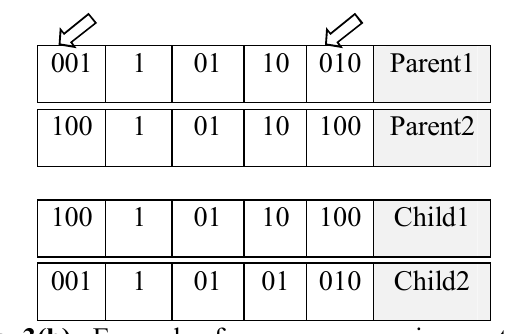
Fig. 3(b). Example of crossover on assignment